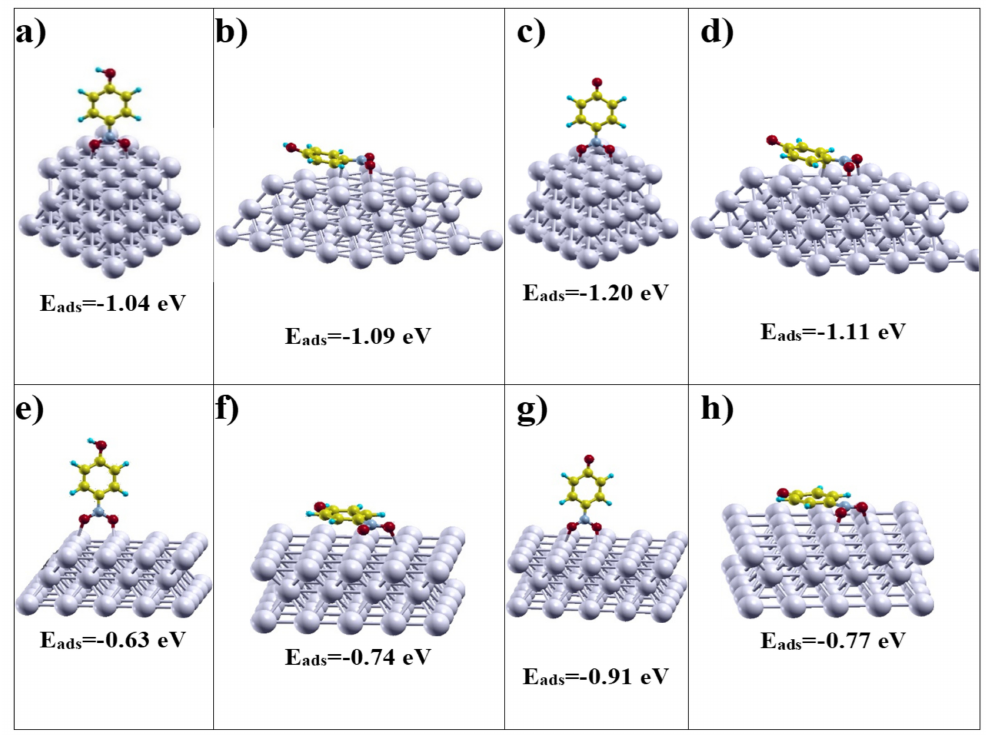
Figure 7. Optimized geometries and adsorption energy ( E ads ) for ( a ) p -nitrophenol perpendicular on Ag (111), ( b ) p -nitrophenol flat on Ag (111), ( c ) p -nitrophenolate perpendicular on Ag (111), ( d ) p -nitrophenolate perpendicular on Ag (111), ( e ) p -nitrophenol perpendicular on Ag (100), ( f ) p -nitrophenol perpendicular on Ag (100), ( g ) p -nitrophenolate perpendicular on Ag (100) and ( h ) p -nitrophenolate perpendicular on Ag